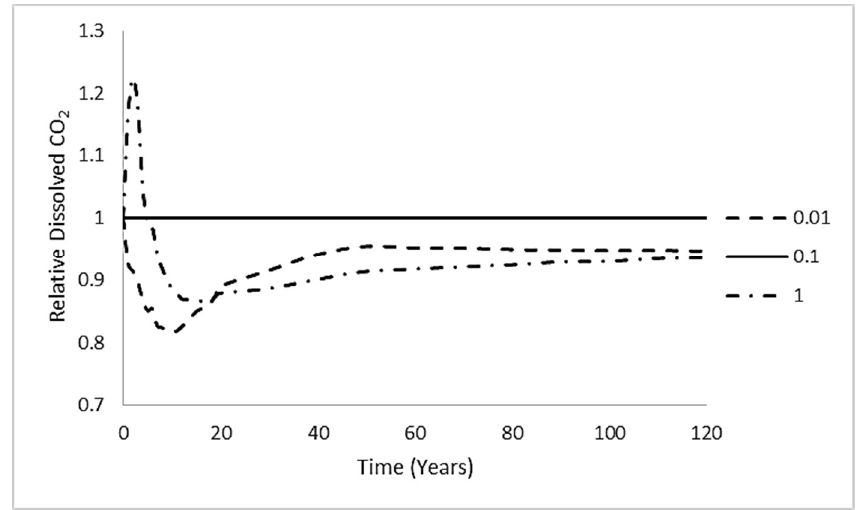
Figure 3. Simulation result for the effect of K v / K h ratio on the amount of dissolved CO 2 vs time by changing K v .